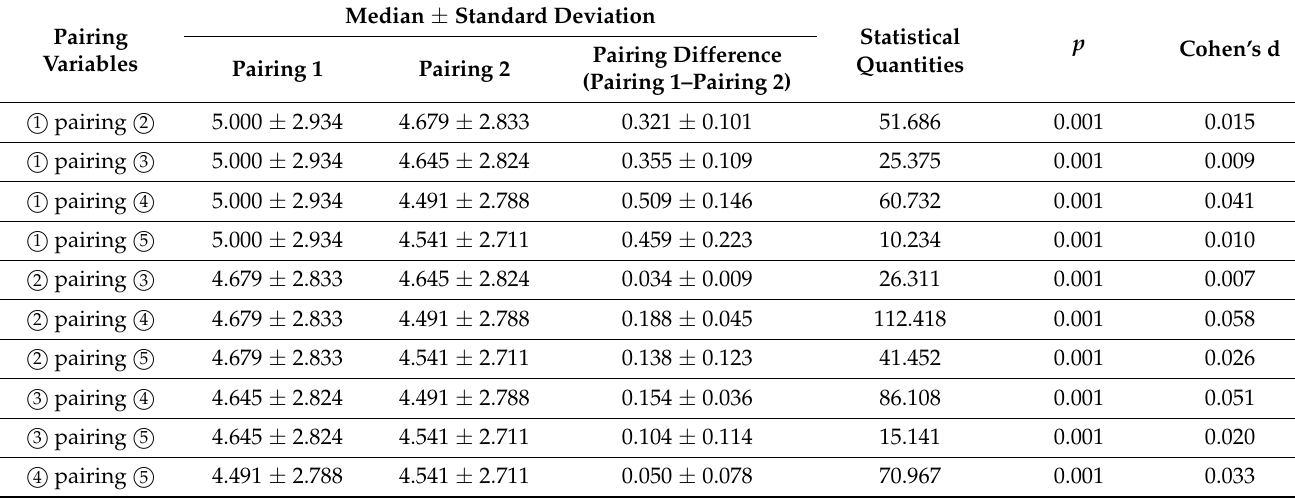
Table 4. The post hoc Nemenyi test using LSTM for multiple